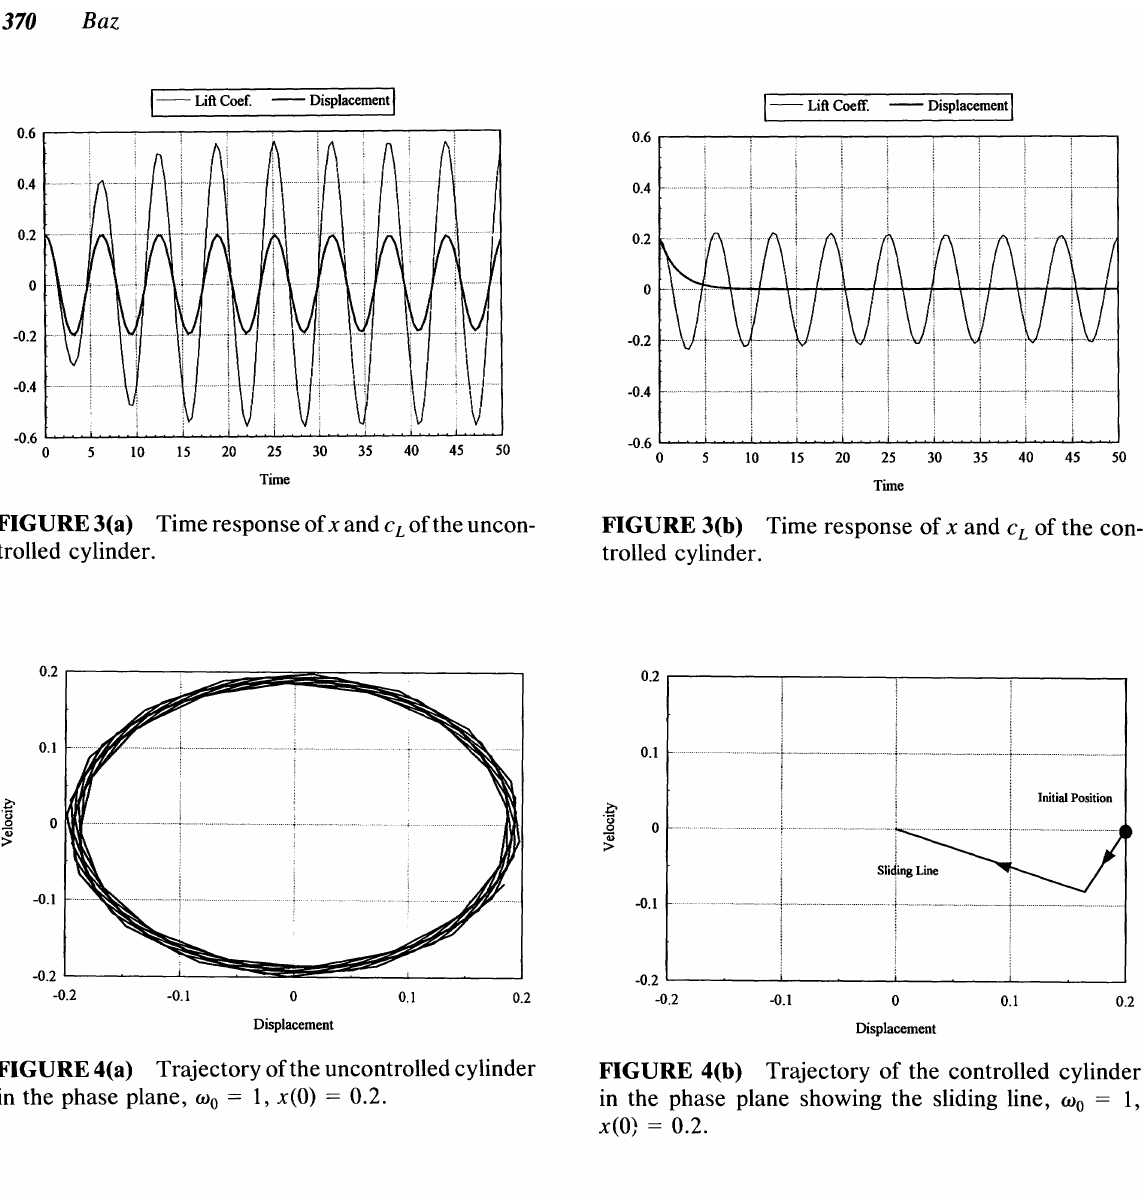
FIGURE 4(b) Trajectory of the controlled cylinder in the phase plane showing the sliding line, Wo = 1, x(O; =